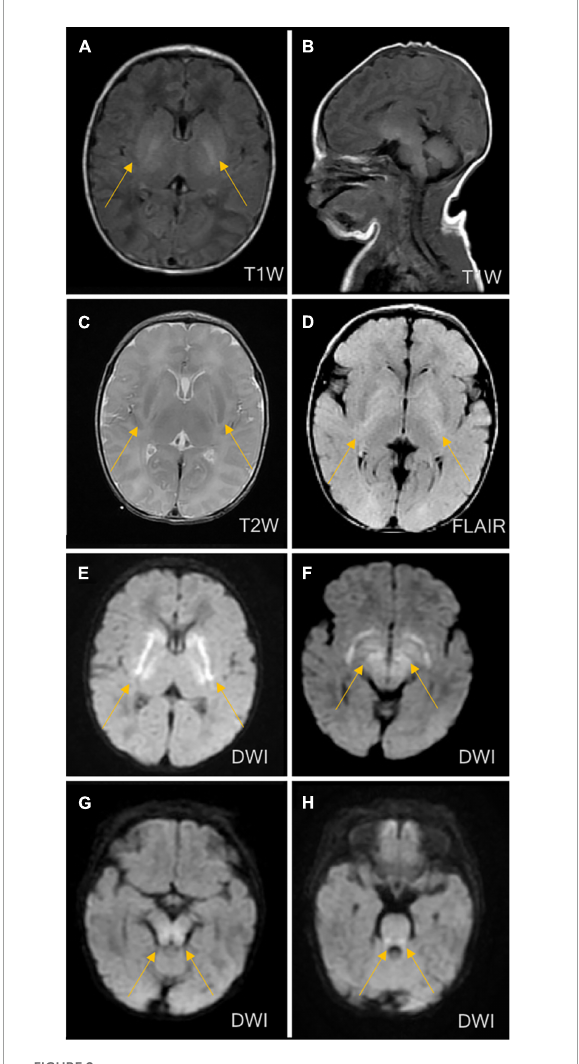
FIGURE2 Brain magnetic resonance imaging (MRI) on the third day of life. MRI showed symmetrical diffuse high-signal shadows in the bilateral basal ganglia, cerebellum, pontine, tegmental and bilateral frontal and parietal cortices, suggesting hereditary metabolic leukoencephalopathy. (A) No abnormal signal intensity in the bilateral basal ganglia on the T1-weighted image (T1WI). (B) Low signal intensity in the bilateral basal ganglia on the T2-weighted image (T2WI). (C) High signal intensity in the bilateral basal ganglia on the diffusion-weighted image (DWI). (D) High signal intensity in the bilateral basal ganglia on fluid-attenuated inversion recovery (FLAIR). (E) High signal intensity in the cerebellum on the DWI. (F) High signal intensity in the pontine on the DWI. (G) High signal intensity in midbrain on DWI. (H) High signal intensity in medulla on DWI.